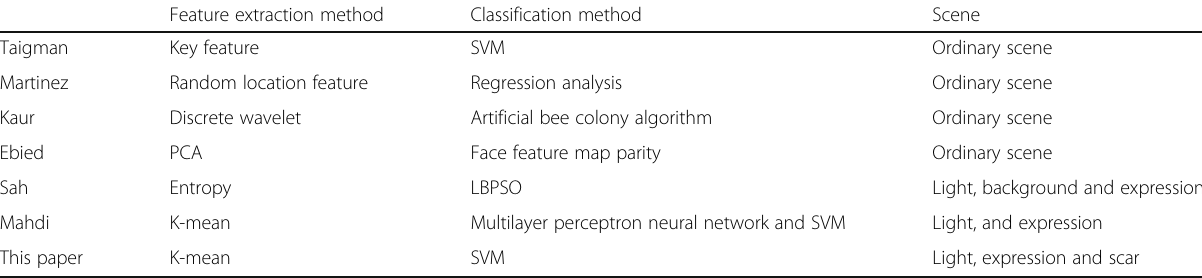
Table 2 Comparison of this article and existing